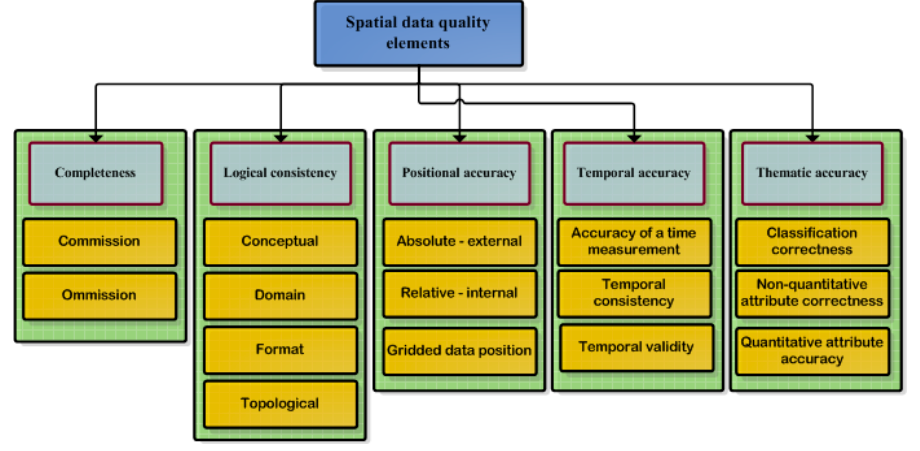
Figure 1. Basic elements and sub ‐ elements of spatial data quality (based on the ISO19157:2013).